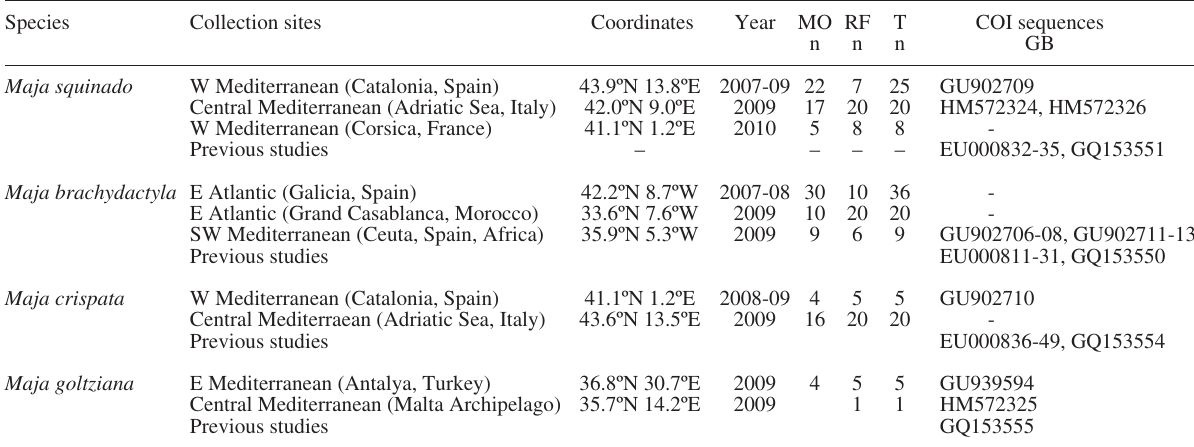
Table 1. – Sampling locations and number of individuals for molecular and morphological studies of Maja . Abbreviations: GB, GenBank accession number; MO, morphological studies; n, number of crabs; RF, RFLP studies; T, total studied individuals. Species